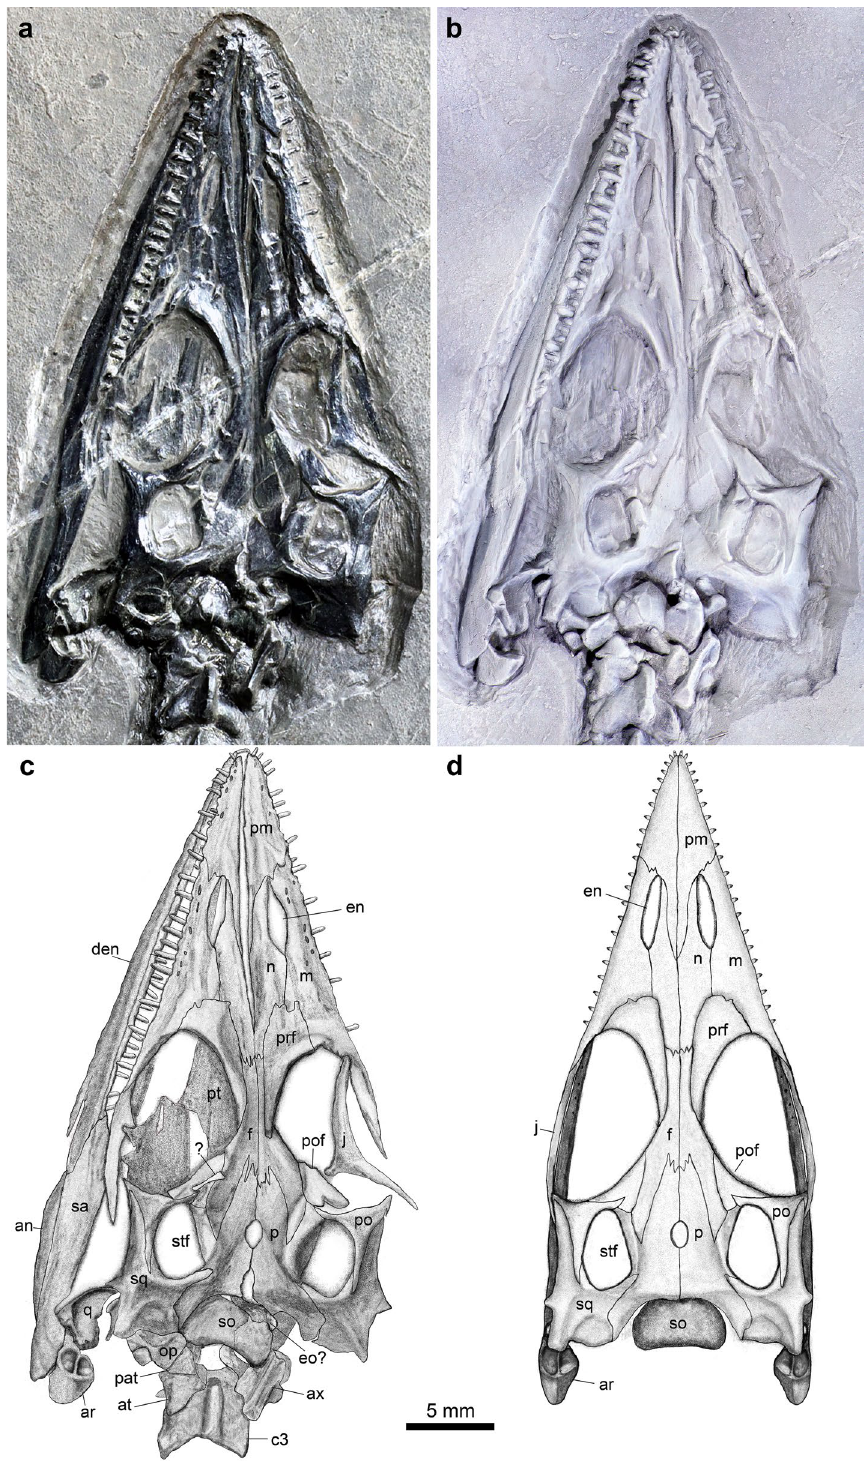
Figure 3. Skull and mandible of Honghesaurus longicaudalis gen. et sp. nov., IVPP V30380. Photo before ( a ) and after ( b ) dusted with ammonium chloride. ( c ) Line- drawing. ( d ) Reconstruction in dorsal view. an, angular; ar, articular; at, atlas; ax, axis; c, cervical vertebra; den, dentary; en, external naris; eo, exoccipital; f, frontal; j, jugal; m, maxilla; n, nasal; op, opisthotic; p, parietal; pat, proatlas; pm, premaxilla; po, postorbital; pof, postfrontal; prf, prefrontal; pt, pterygoid; q, quadrate; sa, surangular; so, supraoccipital; sq, squamosal; stf, supratemporal